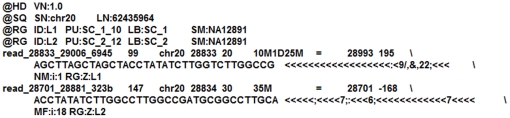
Example of a SAM file [1].